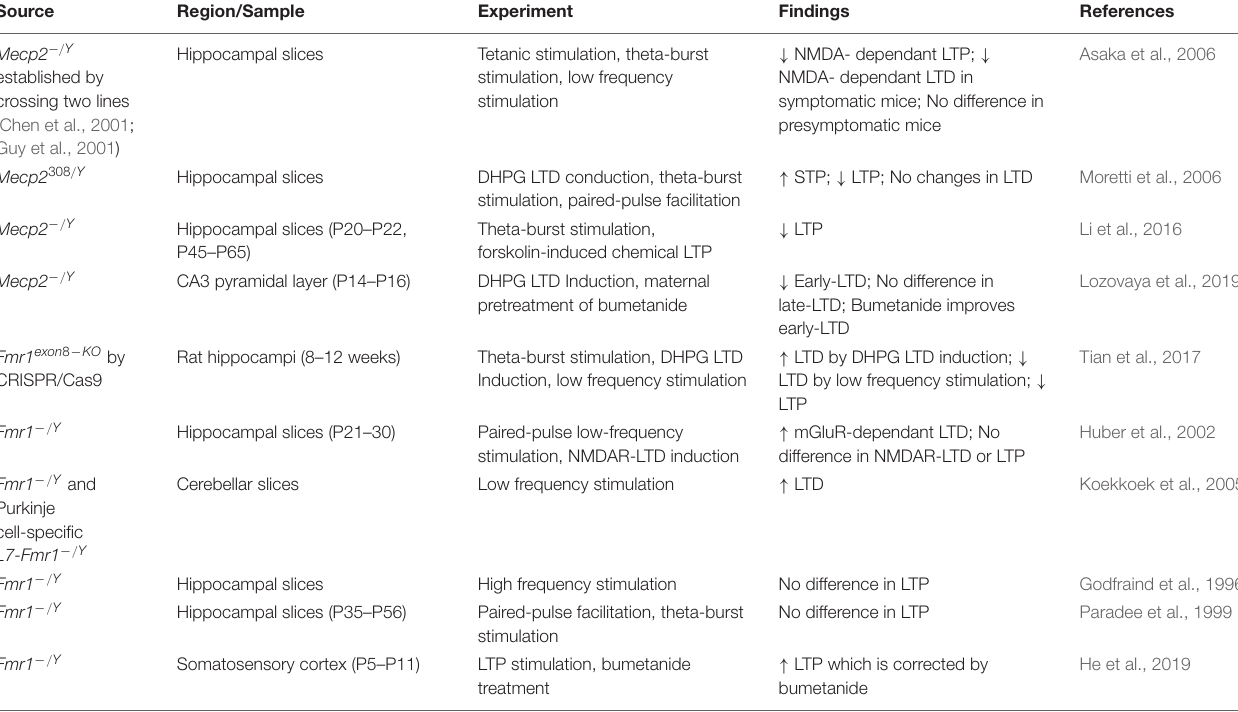
TABLE 3 | Alteration of long-term potentiation and long-term depression in Rett syndrome and Fragile X syndrome.